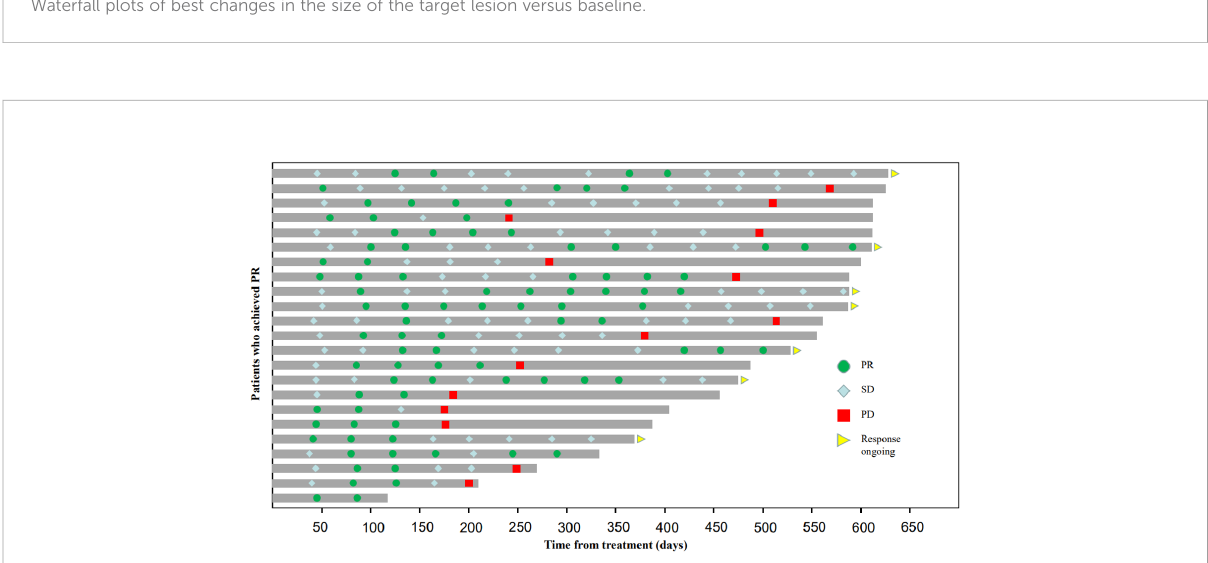
FIGURE 3 Swimmers plot of time on treatment for patients who achieved